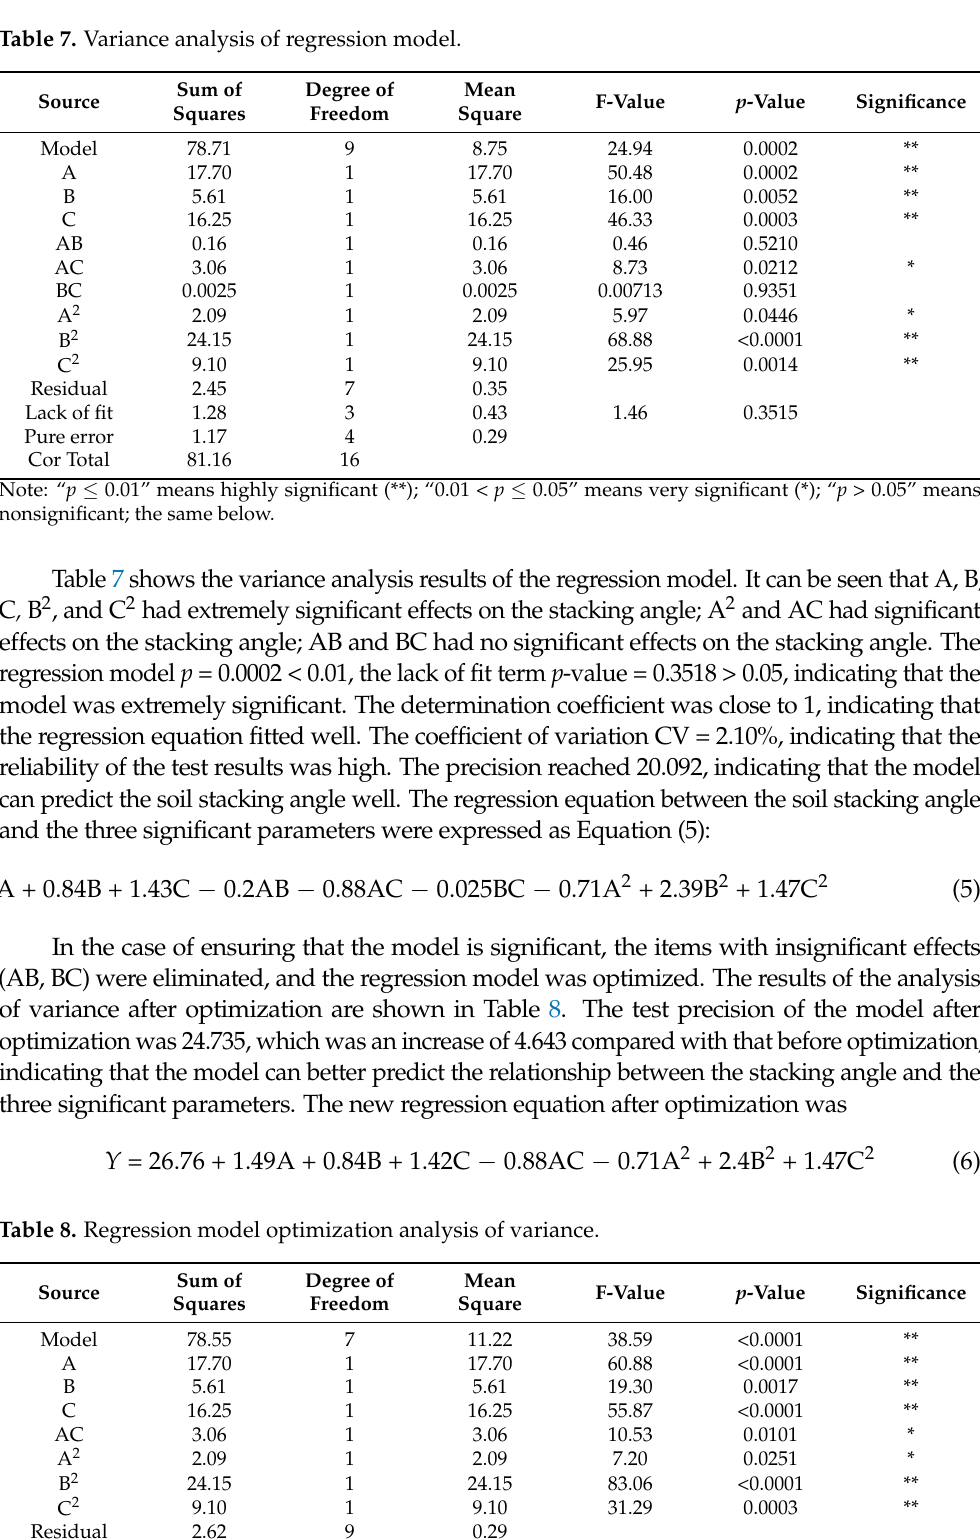
Mean F-Value p Square